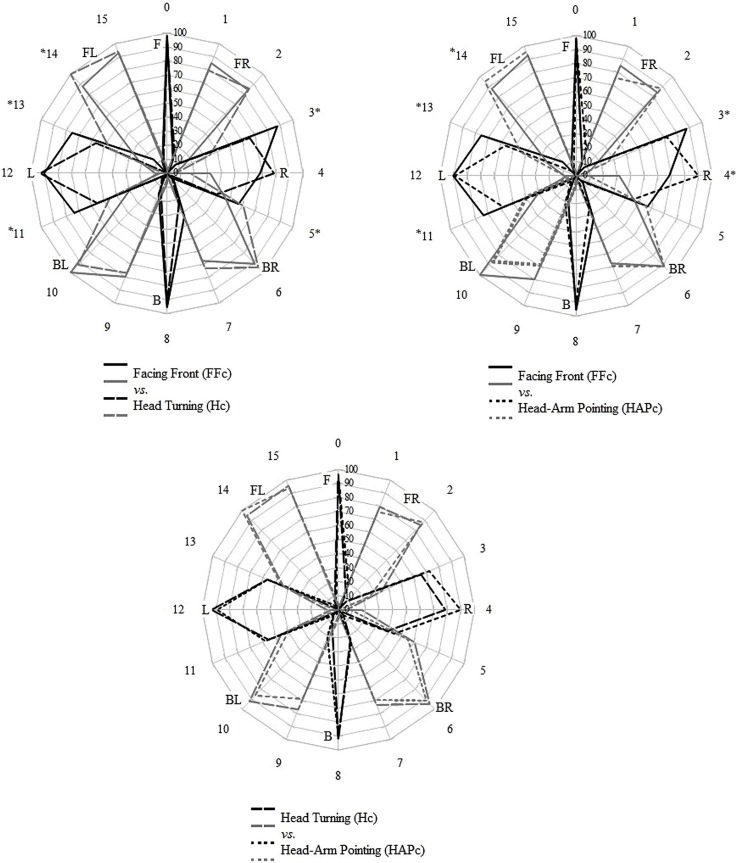
Distribution of direction labels given in the verbal responses for each LS direction. The numbers outside of the circles represent the LSs; the participant was facing LS 0. Black lines correspond to the simple labels (F, L, R, B) and gray lines to the combined labels (FR, FL, BR, BL). Differences between the conditions were found in the directions flagged with asterisks (Chi square tests, original P-value <0.05 with Benjamini-Hochberg correction). The radius of the circle indicates the maximal value of valid responses (0–100%), and the concentric lines indicate steps of 10%.